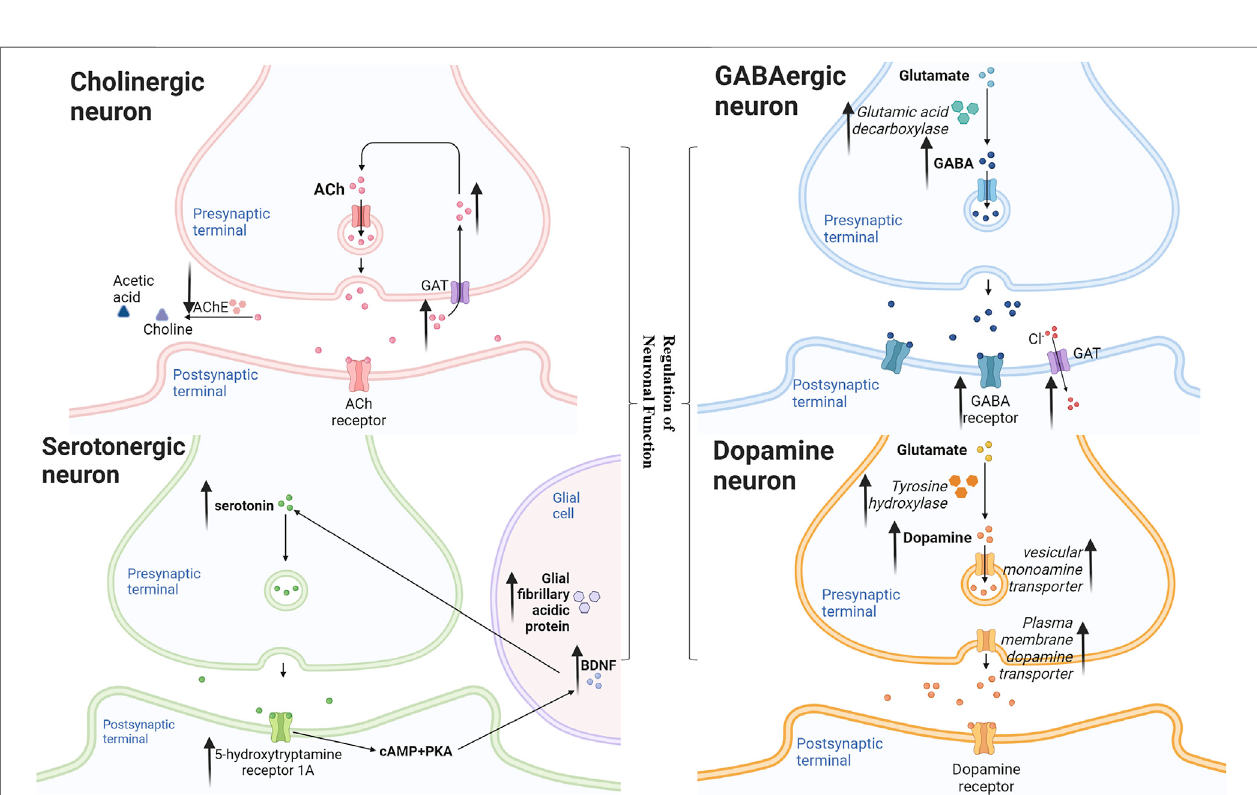
FIGURE 2 | Mechanisms involved in the regulation of neuronal function by neolignans.